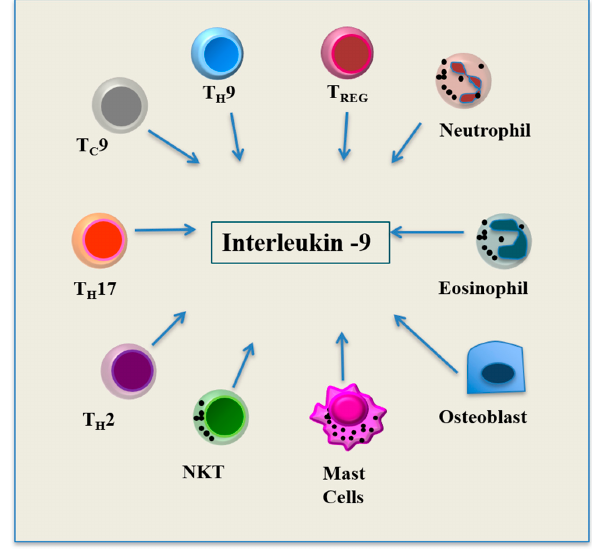
Figure 2. Various cellular sources of IL-9.